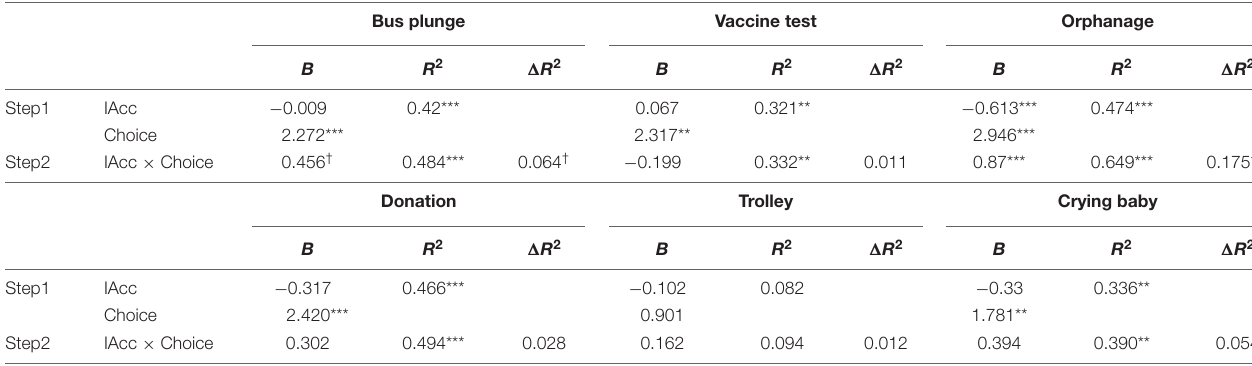
TABLE 4 | Effects of IAcc and moral choice on regret.